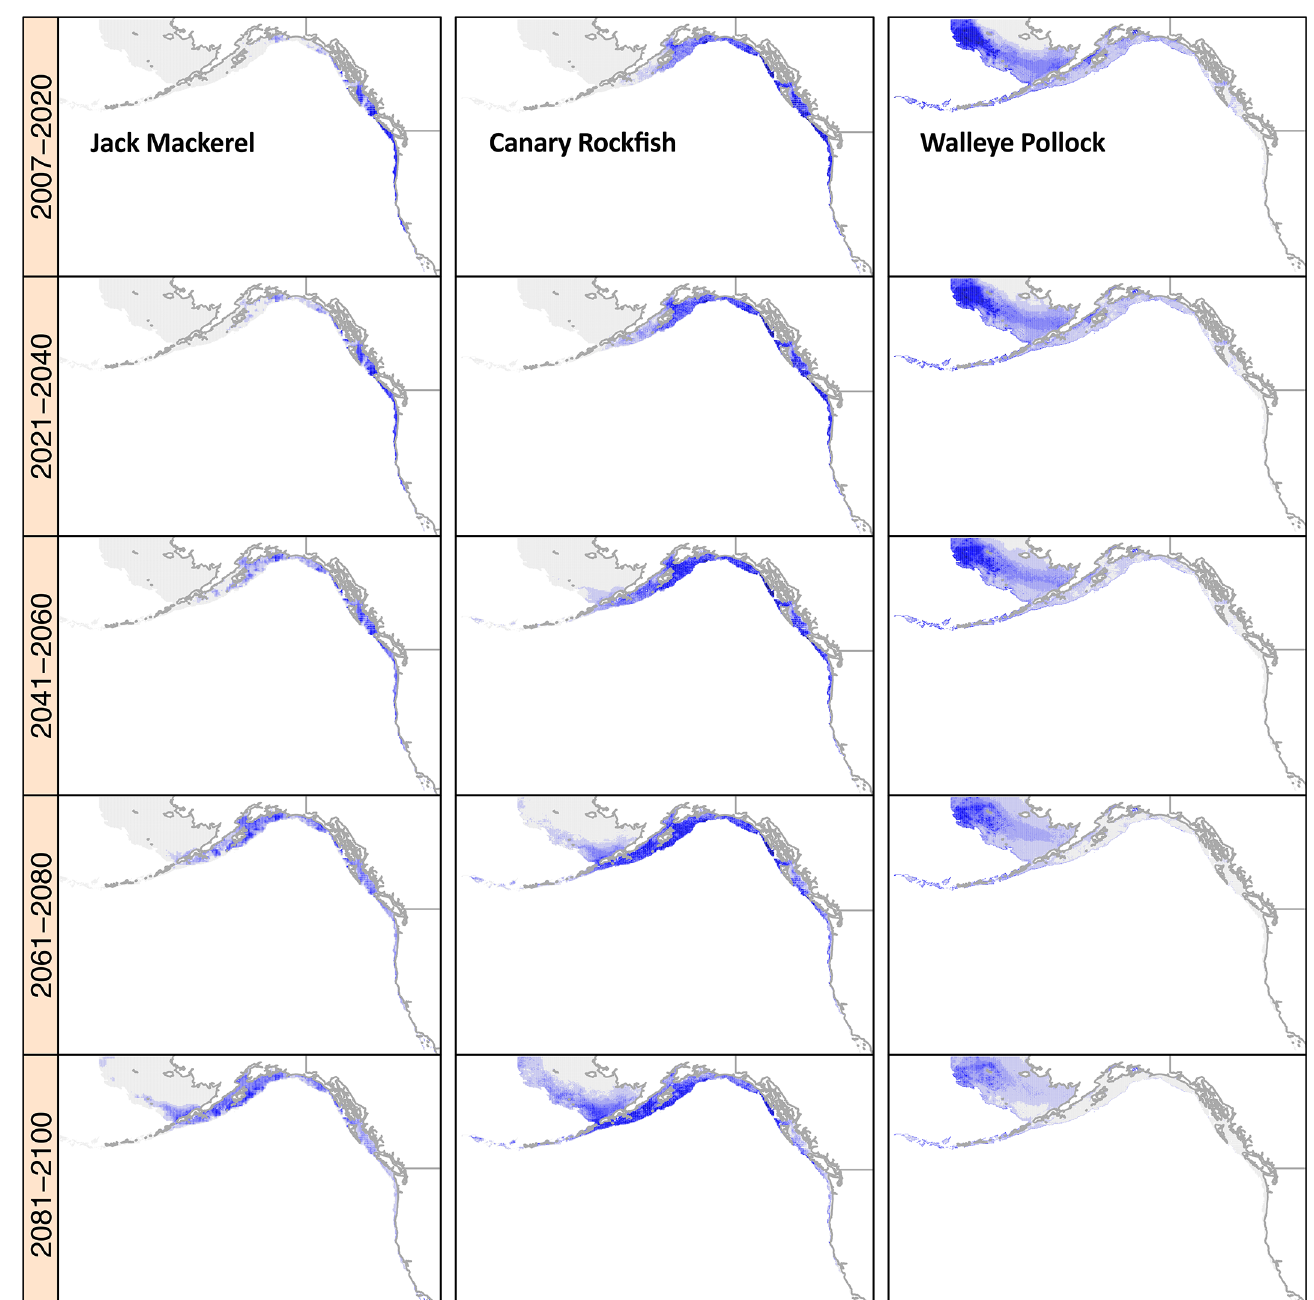
Fig 7. Examples of west coast species projections. Jack mackerel Trachurus symmetricus is in the left-most column, canary rockfish Sebastes pinniger is in the middle column, and walleye pollock Theragra chalcogramma is in the right-most column. Mean annual thermal habitat suitability during summer under RCP 8.5 is shown for twenty-year periods in the 21 st century. Habitat quality is higher in areas of greater blue intensity. Gray areas indicate regions of the projection grid that are not suitable thermal habitat. White areas indicate regions not included in the projections (either land or deep water).